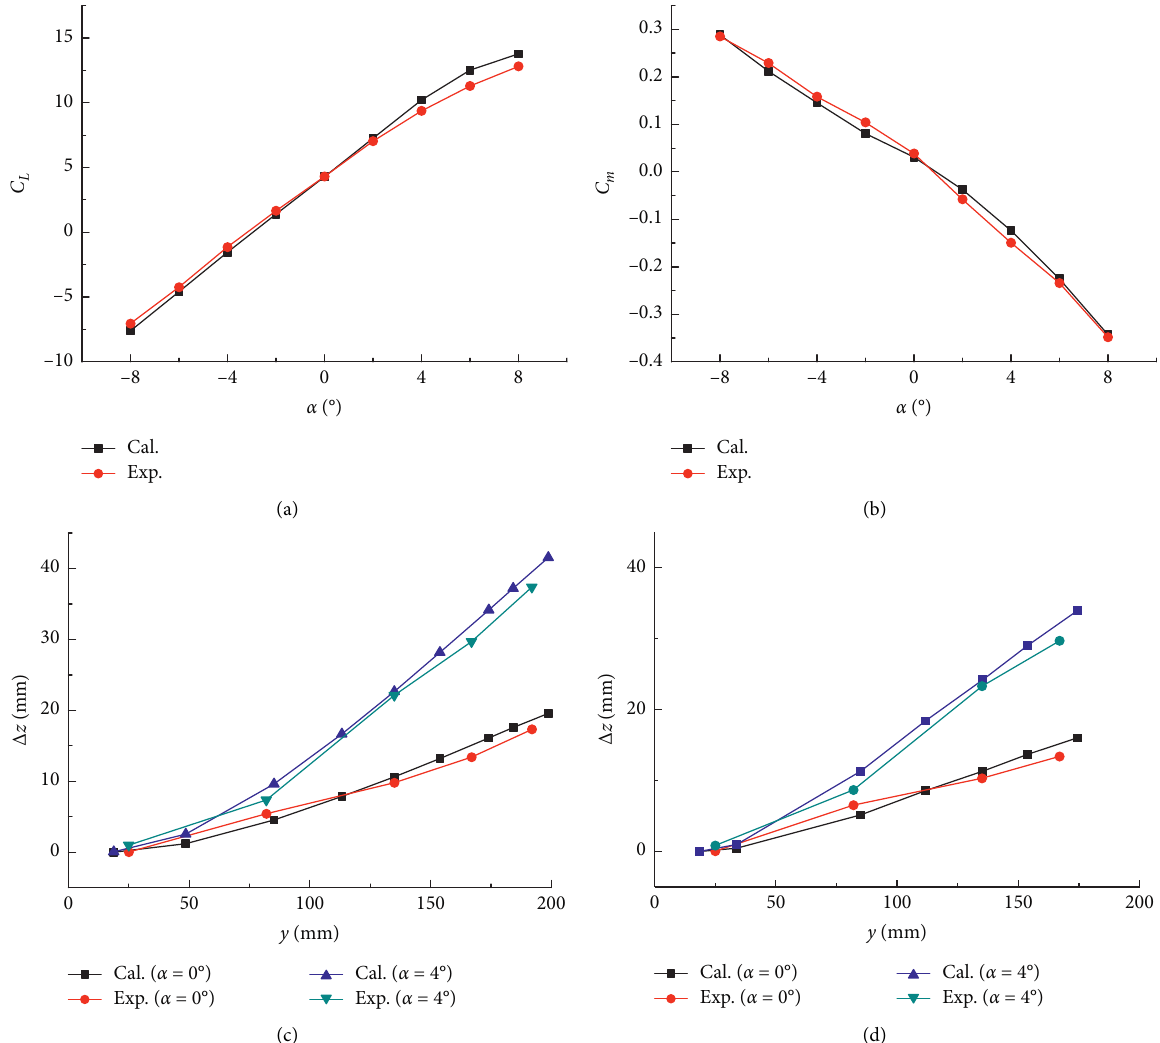
Figure 6: Comparison between numerical computation and wind tunnel test. (a) C (rear wing).